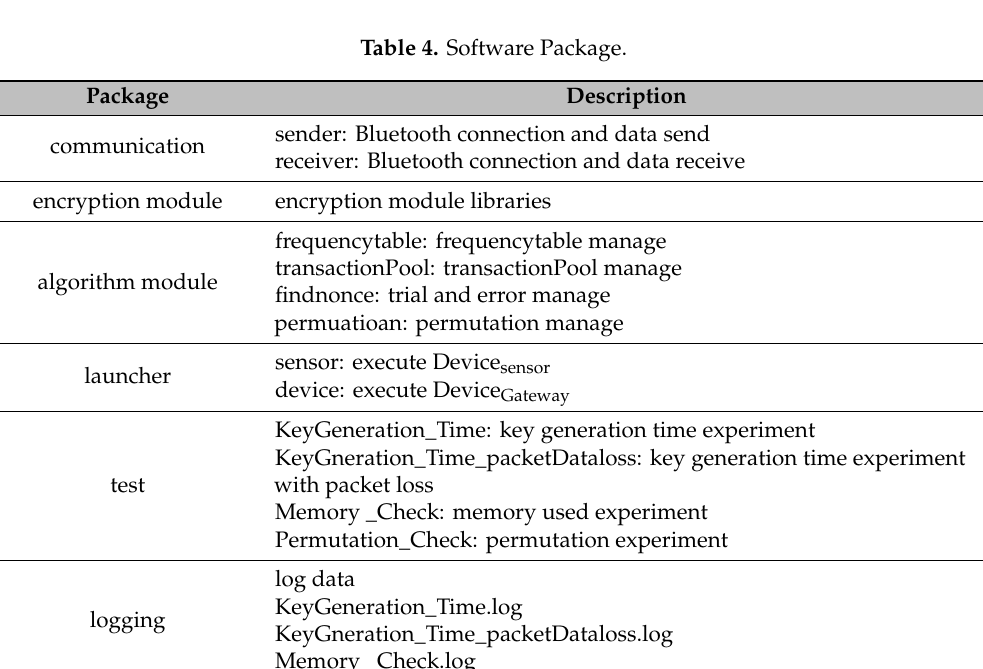
Table 4. Software